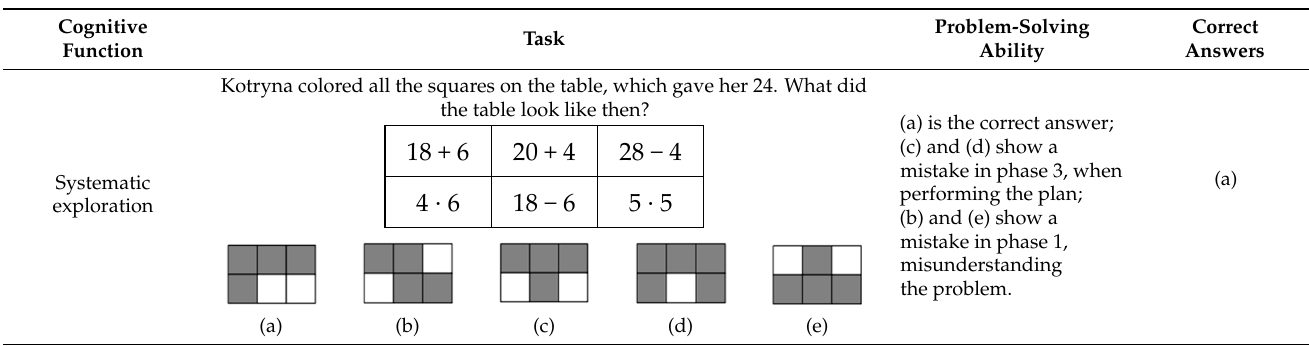
Table 1. Structure of diagnostic cognitive ability test.